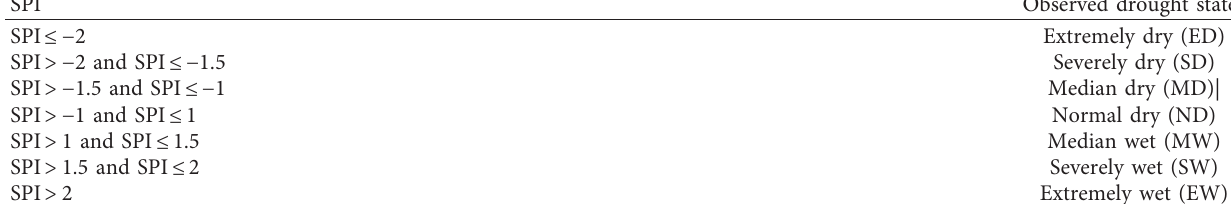
Table 2: The classification of the SPI for various drought states